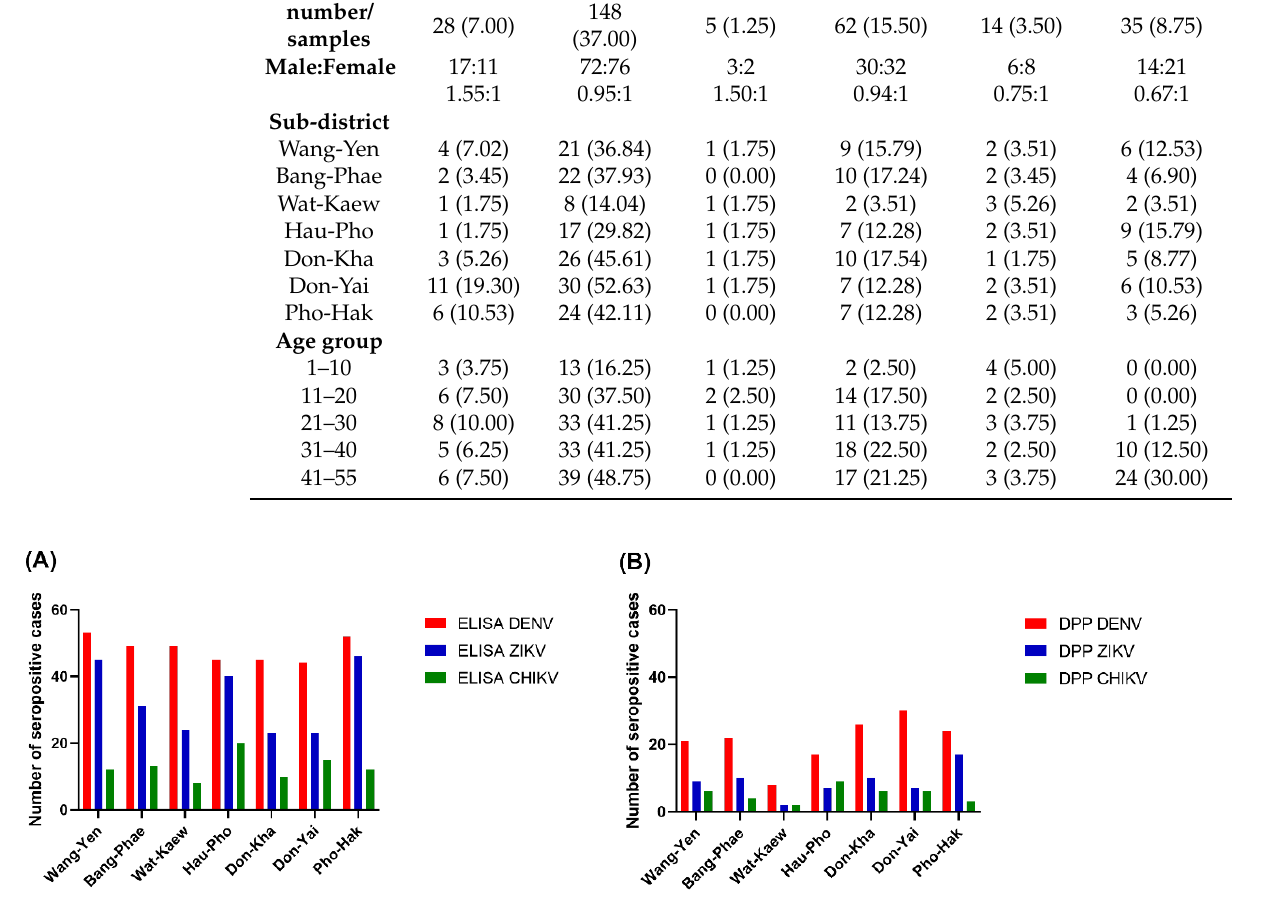
Figure 3. Seroprevalence of three arboviruses by residential area. ( A ) The ELISA results; ( B ) The DPP ® ZCD IgG results. The x-axes describe the DENV (red), ZIKV (blue), and CHIKV (green) distributions for the seven sub-districts of Bangphae district, Ratchaburi province, Thailand. The y-axes represent the seroprevalence, as shown by the number of cases.